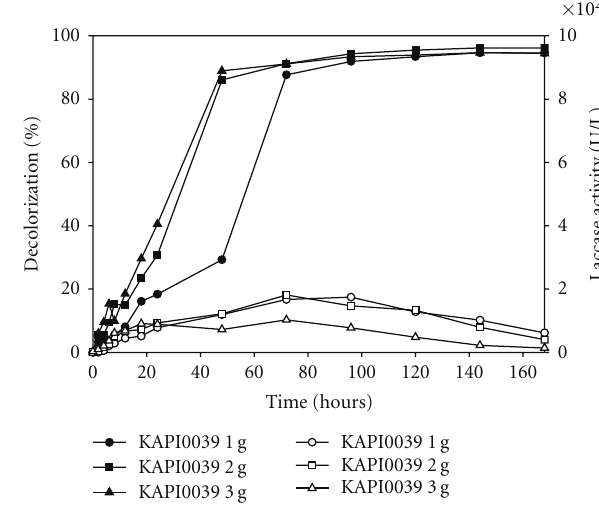
Figure 3: The e ff ect of fungal inoculum size on %decolorization of RBBR dye solution and Lac activity after cultivation with Datronia sp. KAPI0039; close symbol = %decolorization; open symbol = Laccase activity.